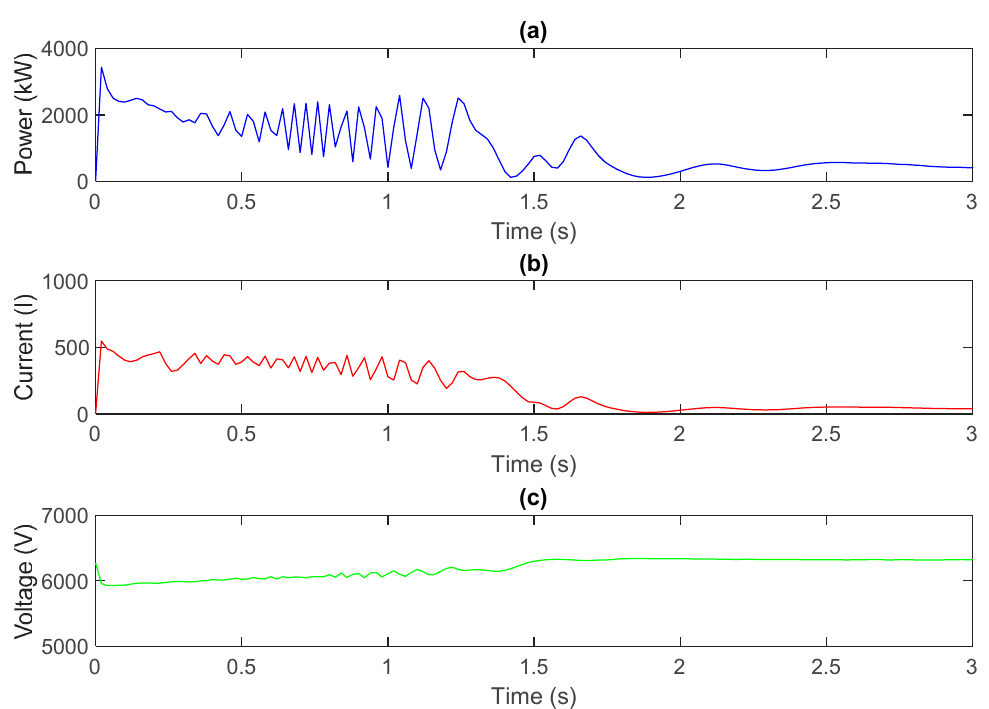
Figure 5. Start-up of the LSPMSM SMH-1732T motor with a filled ball mill after two hours of downtime: ( a ) active power, ( b ) current intensity, ( c ) voltage.